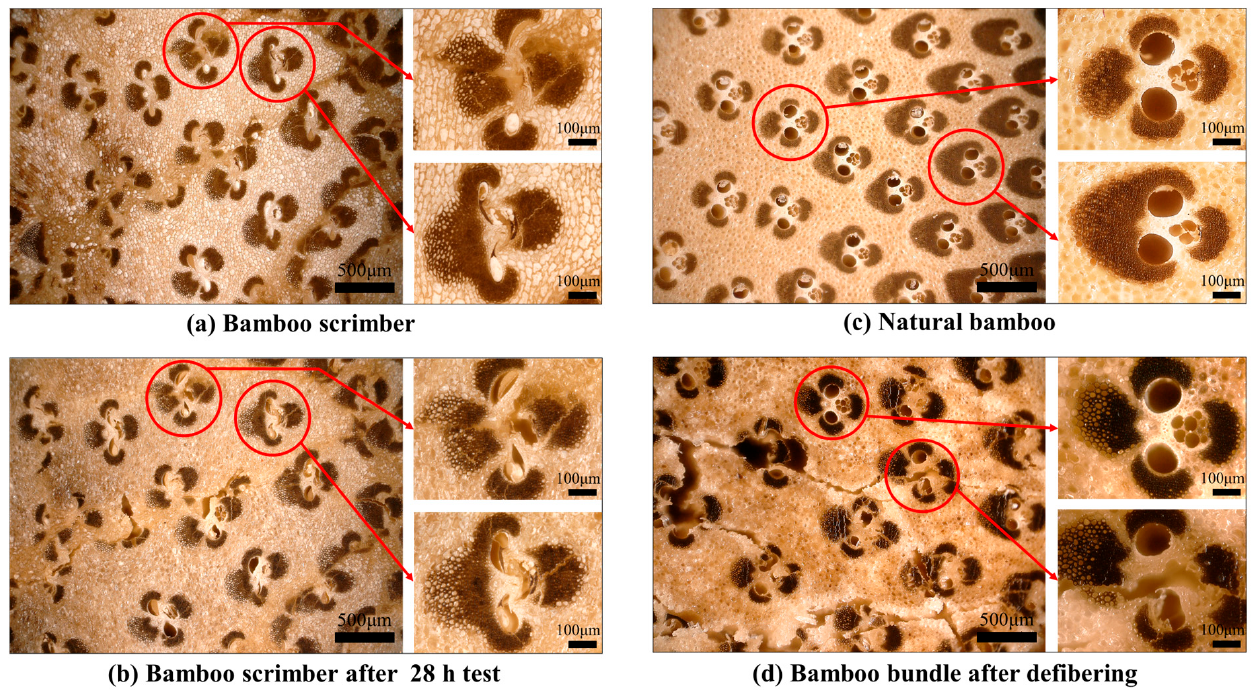
Figure 4. Deformation of cells in the cross-section of bamboo and bamboo scrimber at different stages: ( a ) bamboo scrimber, ( b ) bamboo scrimber after 28 h test, ( c ) natural bamboo, ( d ) bamboo bundle after de-fibering.